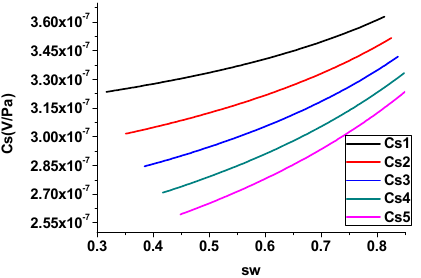
Figure 9. Influence of water film thickness on streaming potential coupling coefficient (slug flow). Figure 10 studies the influence of pore size on the streaming potential coupling coef- ficient of the capillary under slug flow. The pore radius is taken as 0.2 μm , 0.4 μm , 0.6 μm , 0.8 μm , and 1 μm , respectively. It can be seen from the figure that the coupling coefficient gradually increases with the increase in pore radius. As the pore radius increases, the streaming current will increase, and the change in pore fluid conductivity is small, so the coupling coefficient will become larger.